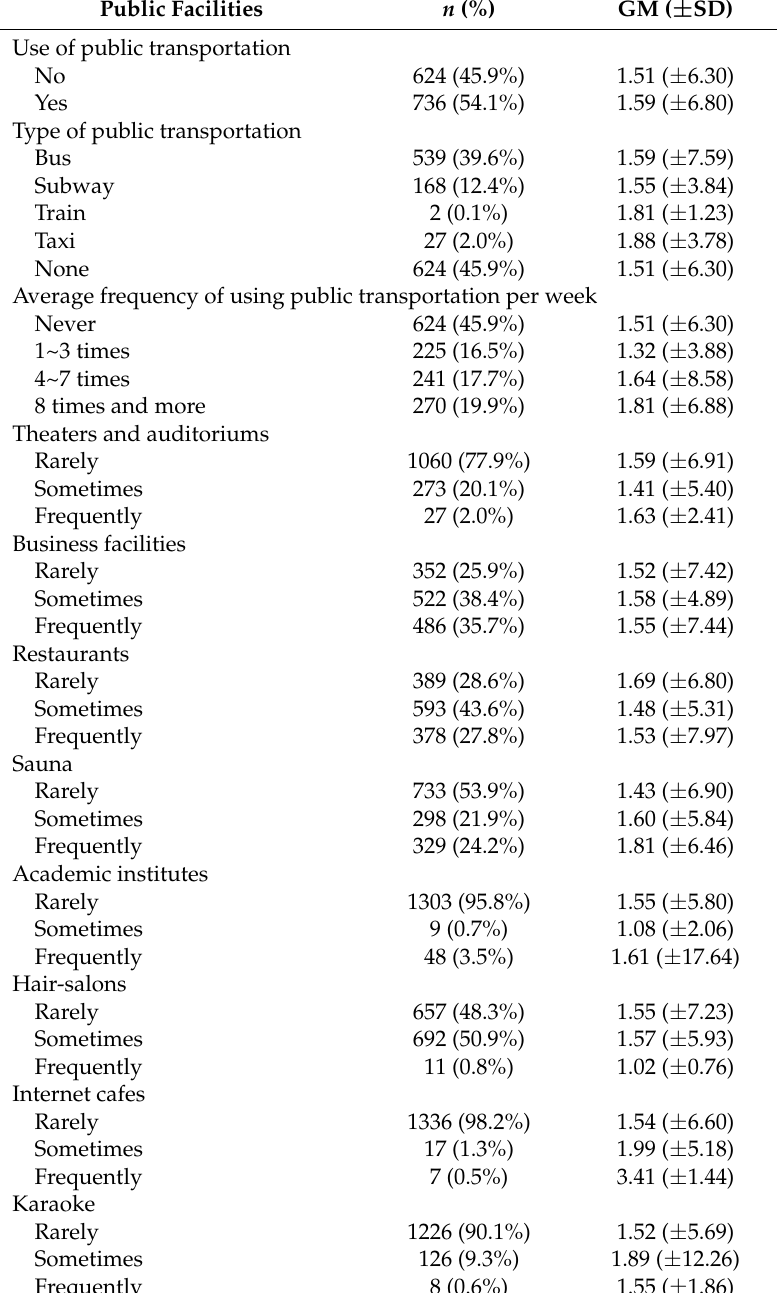
Table 2. Distributions of factors related to the usage of public facilities and their associations with creatinine-adjusted urinary cotinine concentrations (ng/mg